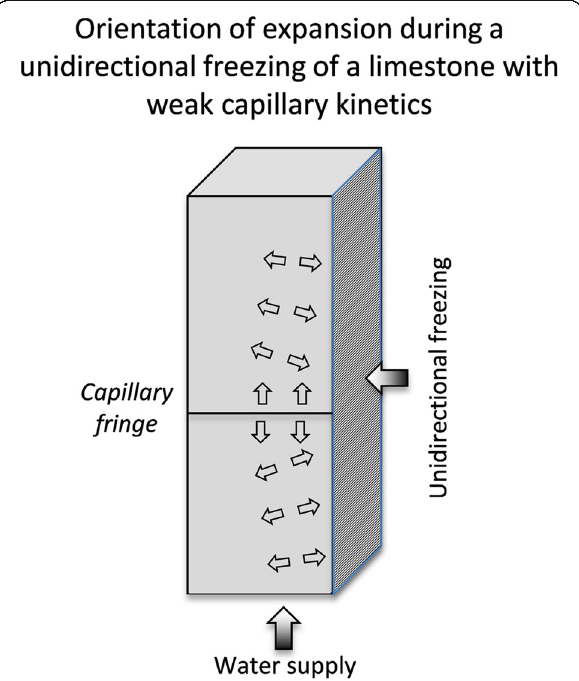
Fig. 9 Schematic distribution of expansion strains during unidirectional freezing of a sample supplied by